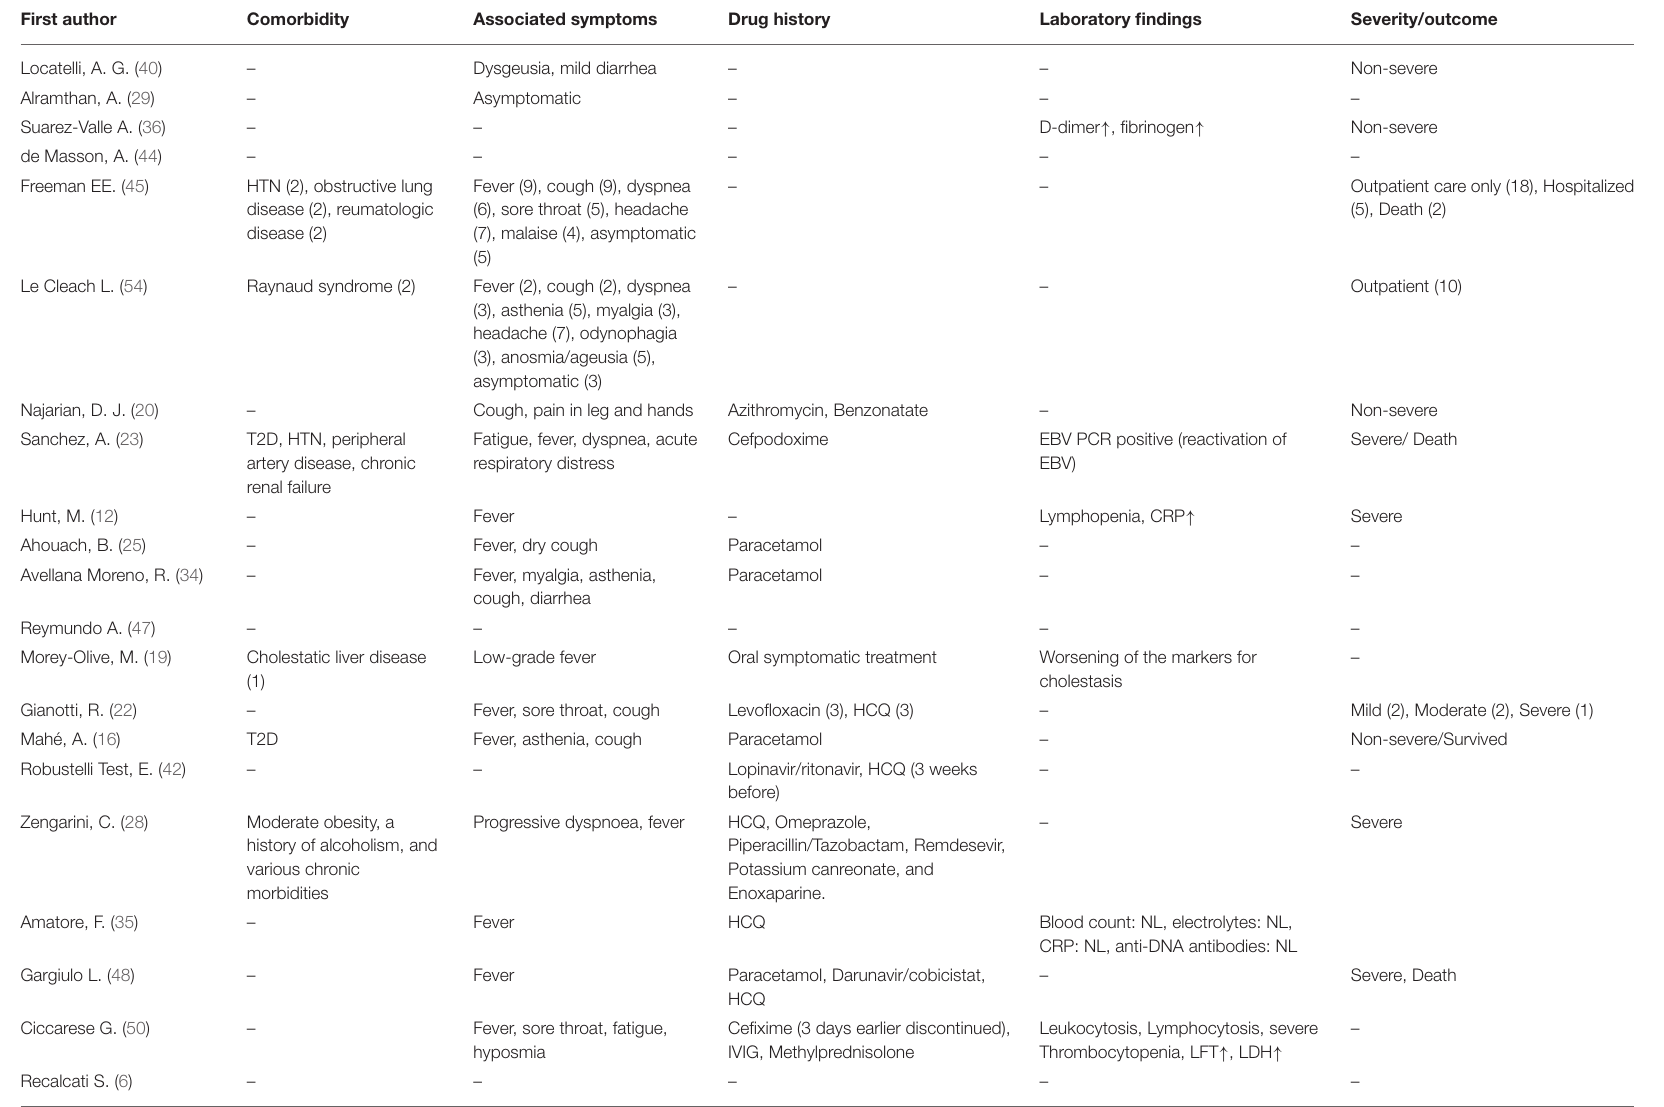
TABLE 3 | Characteristics of the confirmed COVID-19 patients with skin